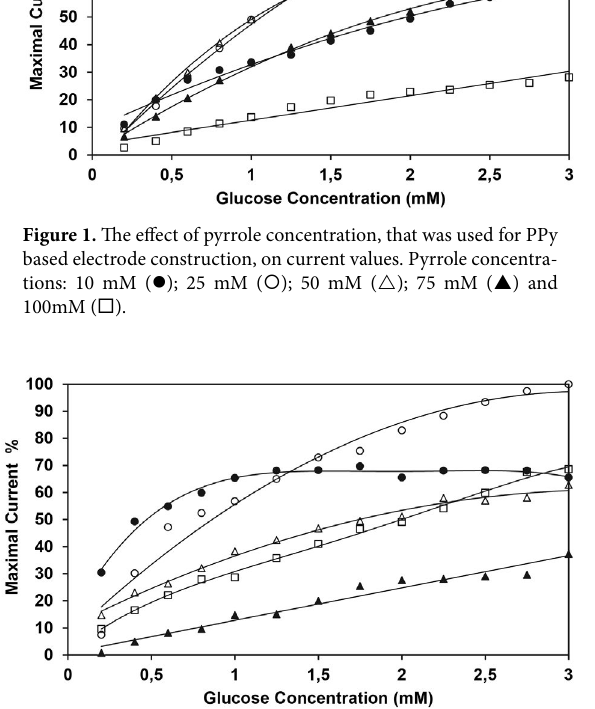
Figure 2. Current values depending on glucose concentration of GOD electrode constructed by POA layer obtaining by different o-anisidine concentrations as 40 mM (  ); 50 mM (  ); 60 mM (  ); 70 mM (  ) and 80mM (  ).